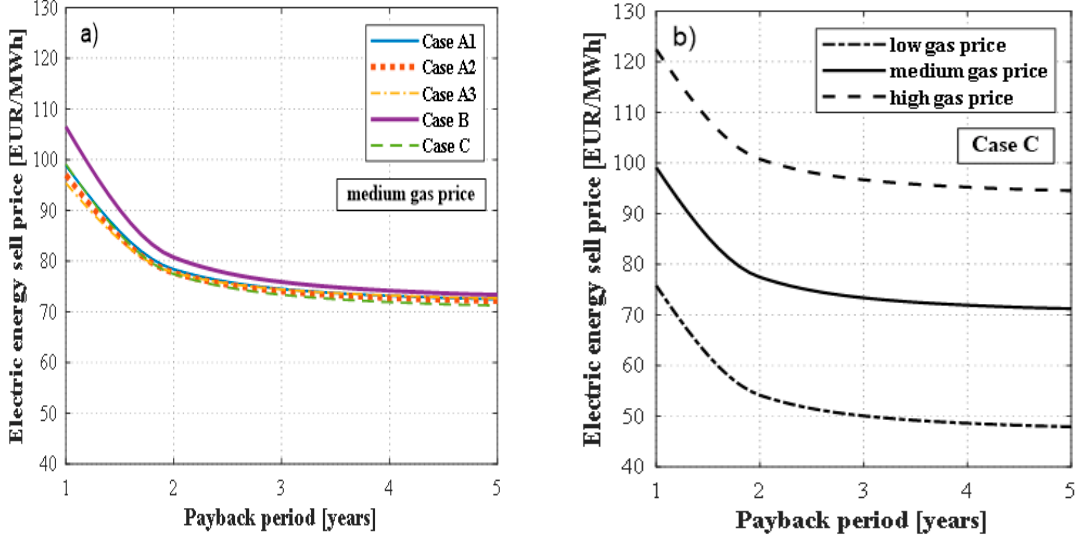
Figure 13. Electric energy sell price to return on the investment in a given payback period: ( a ) Comparison between the different ICE + ORC configurations; ( b ) Influence of the natural gas price value.